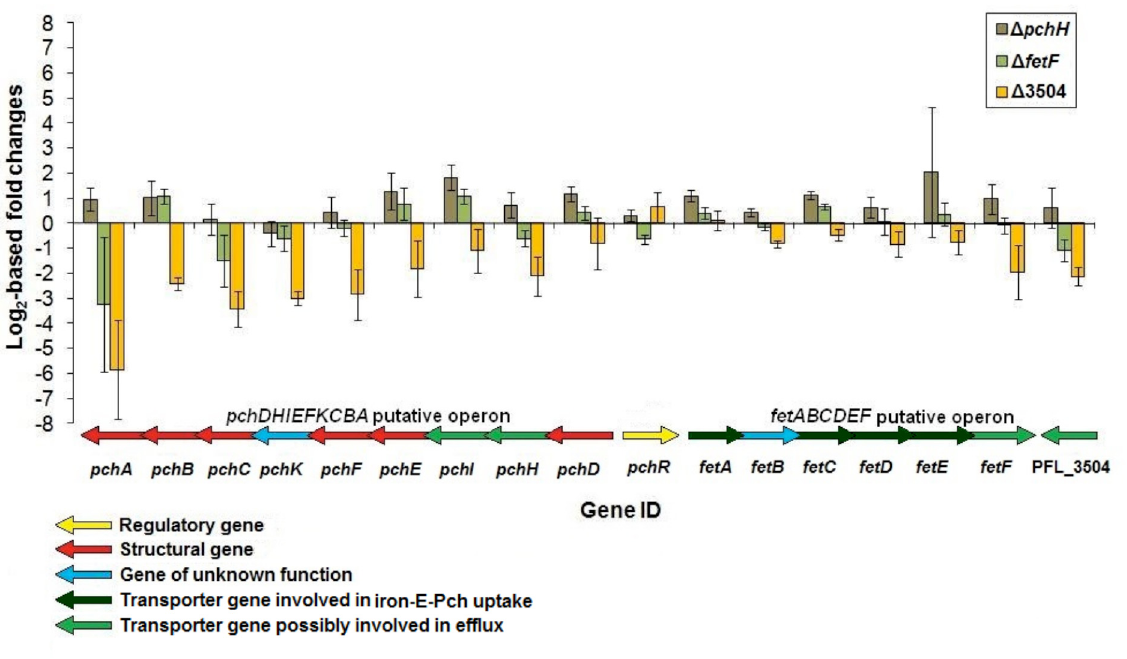
Fig 3. Transcriptional profiling of genes located around the enantio-pyochelin biosynthetic gene cluster of P . protegens Pf-5. Transcript levels were determined by qRT-PCR and the fold change (log 2 ) of each transcript is shown for strains Δ pchH , Δ fetF and Δ 3504 relative to WT Pf-5. qRT-PCR on the truncated genes was performed on non-truncated gene regions. Error bars represent standard deviations between replicates. Coloured arrows depict the corresponding gene organization with the putative operons of the E-Pch biosynthetic gene